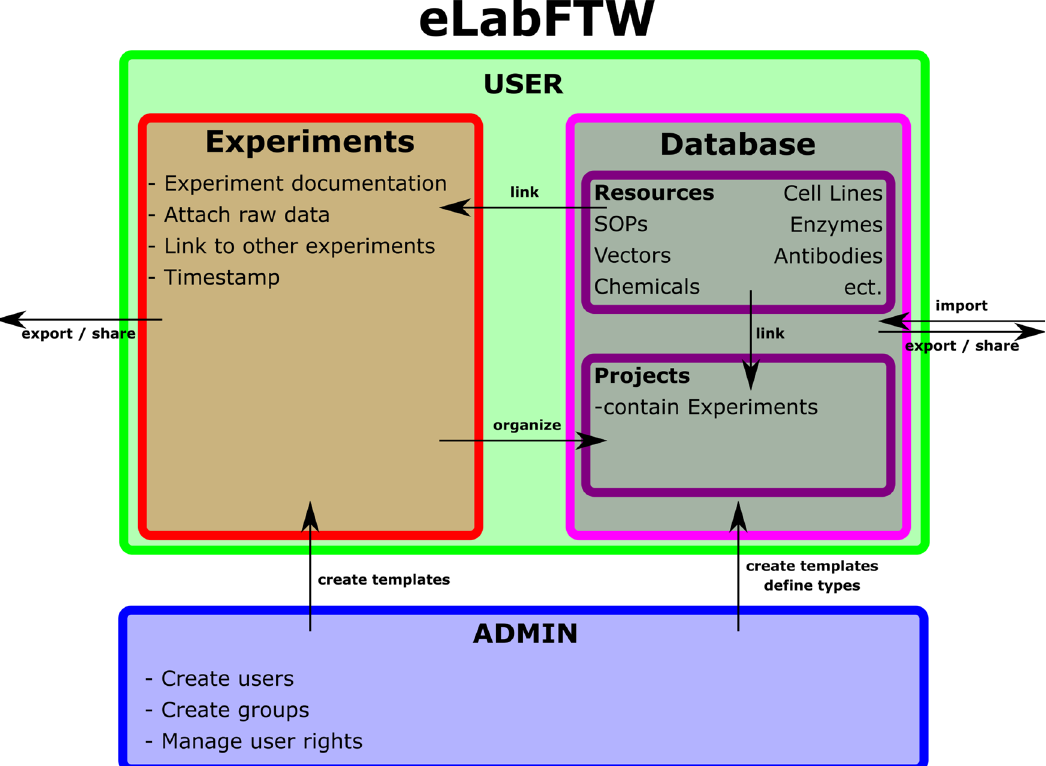
Figure 1. Configuration of eLabFTW as being used by our